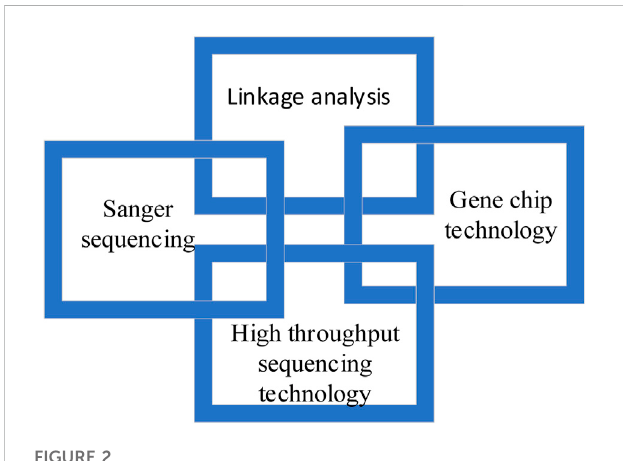
FIGURE 2 Common molecular diagnostic techniques for